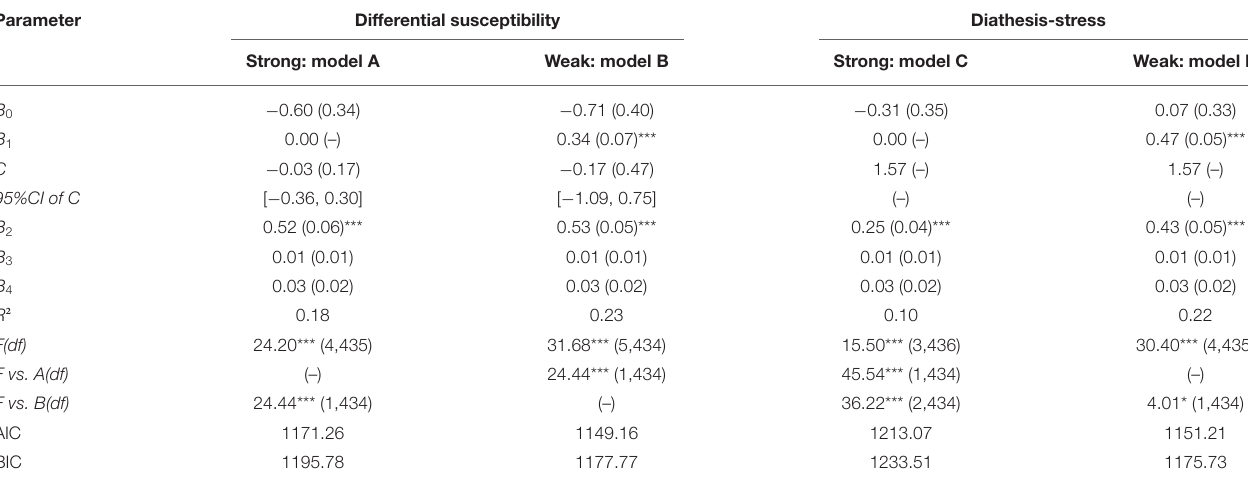
TABLE 3 | Re-parameterized regression analyses for participants.